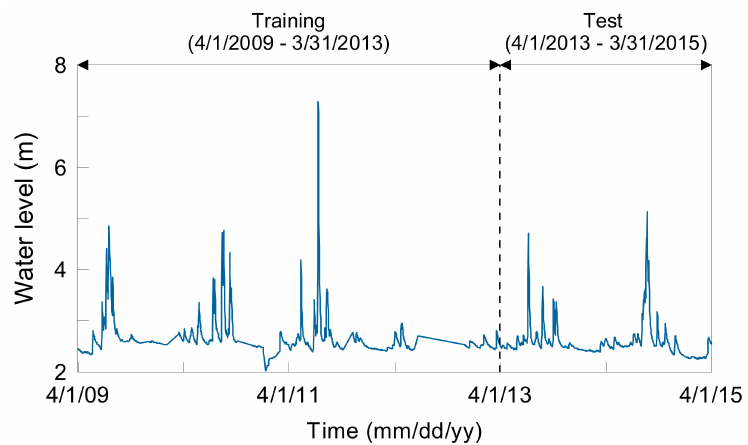
Figure 3. Time series of water level of the Upo wetland over time. Training period is from 1 April 2009 to 31 March 2013 and test period is from 1 April 2013 to 31 March 2015.